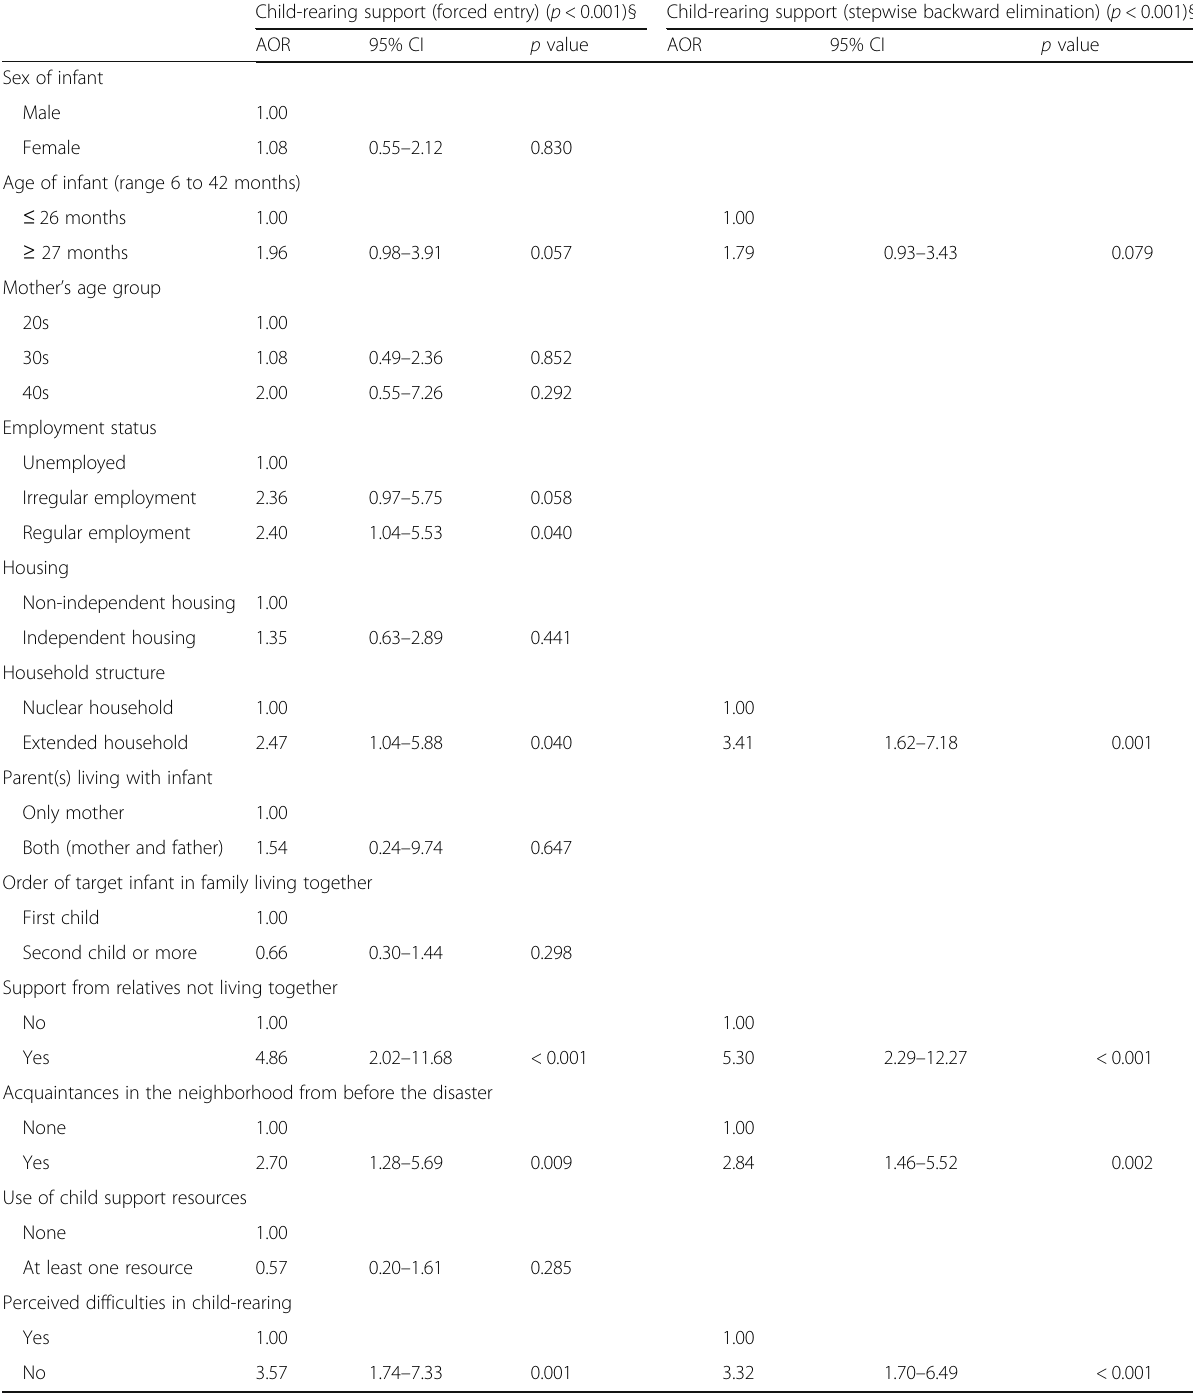
Table 5 Factors related to the obtainment of social support by child-rearing support category ( n = 215) Child-rearing support (forced entry) ( p <